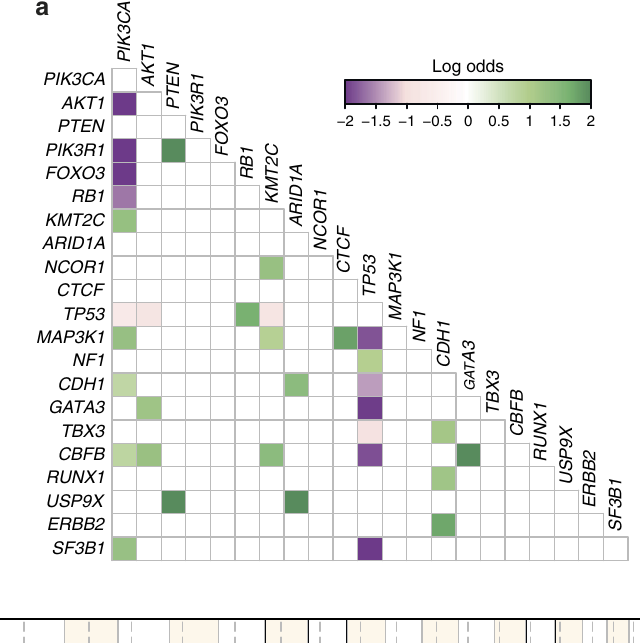
Figure 3 | Patterns of association between somatic events. ( a ) Pairwise association plot for 40 Mut-driver genes in 2,433 samples. Purple squares represent negative associations (mutually exclusive mutations); green squares represent positively associated events (co-mutation). The colour scale represents the magnitude of the association (log odds). We considered all genes mutated in at least 0.5% of the entire cohort, and only associations at FDR ¼ 0.1 are shown (Fisher’s exact test). ( b ) Association plot of CNAs and Mut-driver gene mutations. Top panel: significantly recurrent copy number aberrations (CNAs) identified by GISTIC2 are shown across the genome, along with the percentage of samples affected by the particular CNA. Bottom panel: plot showing Mut-driver gene mutations associated with CNAs. Associations (Ass.) with amplifications and deletions are coloured red and blue respectively, and the colour scale corresponds to the magnitude of the association (log odds). Associations with dots represent mutual exclusivity and those without dots represent co-occurrence. Only genes with at least one significant association (Fisher’s exact test; FDR ¼ 0.01) are shown, and only associations with absolute log odds X log(2) were